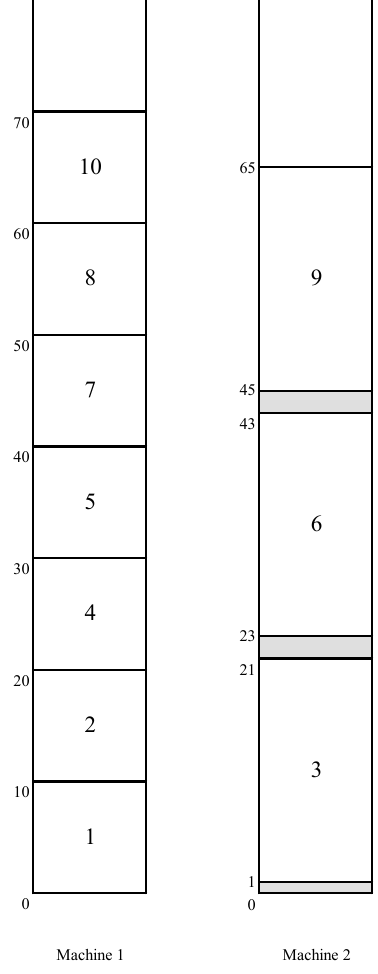
Figure 1. Initial LDTC schedule σ